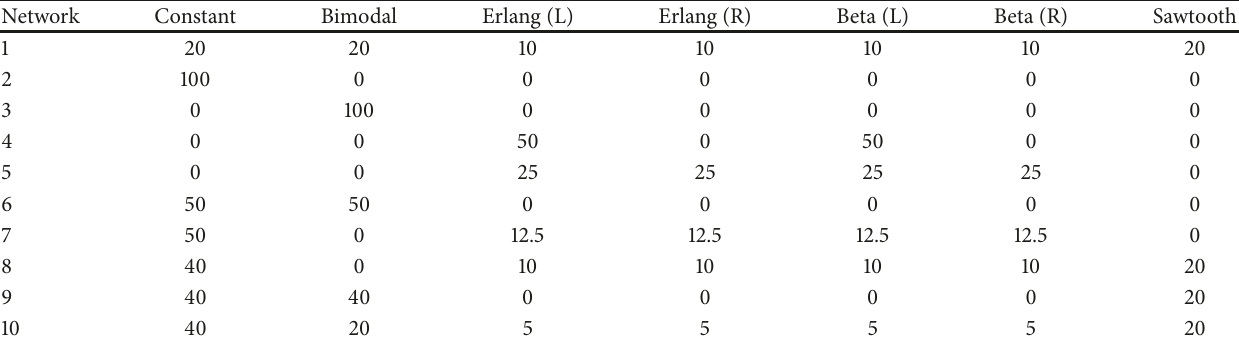
Table 2: Percentage of testing networks comprised by each type of distribution.